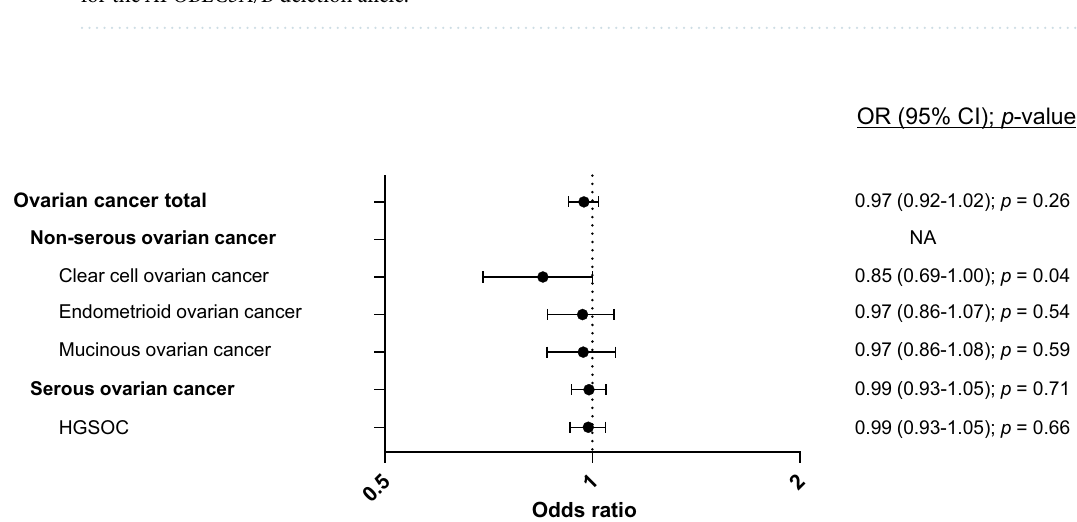
Table 2. SNP rs12628403* and risk estimates for ovarian cancer in OCAC. *SNP rs12628403 used as a marker for the APOBEC3A/B deletion allele.